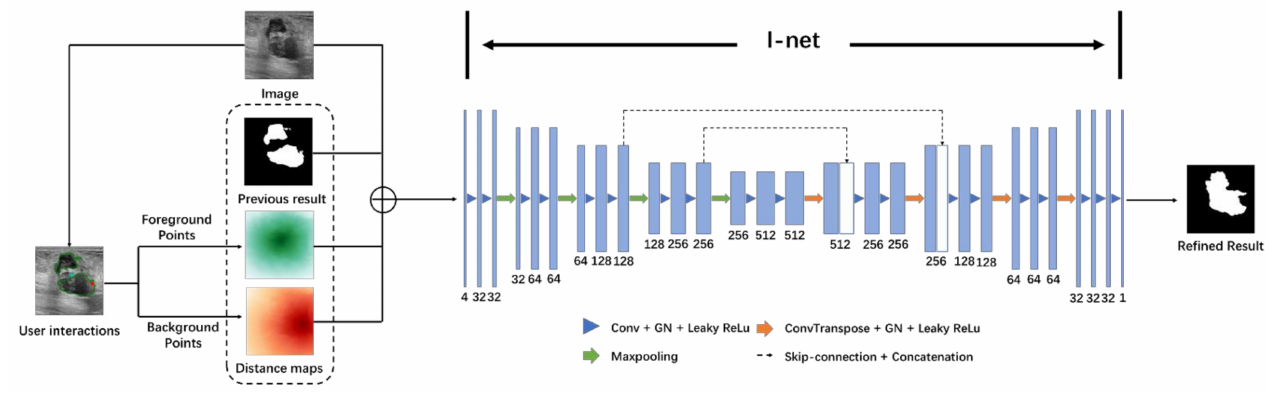
Figure 1. Framework of the proposed method WDTISeg. The cyan dots and red dots in the segmentation represent foreground points and background points, respectively. The number below each block is the number of feature